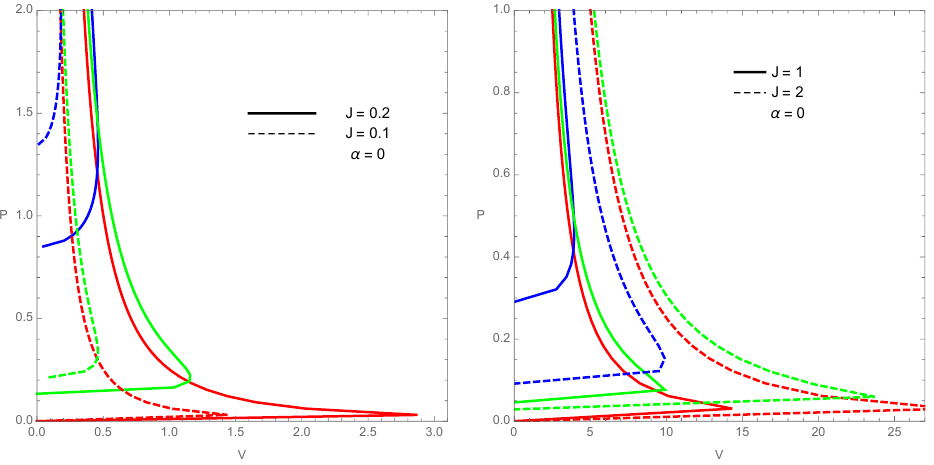
Figure 5 . PV diagram for (cid:11) = 0, (cid:13) = 1 (pure exotic BTZ black hole). The other parameters are J = 0 : 1 ; 1 ; 2 ; 3, and T = 0 : 001 (red), T = 0 : 5 (green), T = 2 (blue). In the case of exotic BTZ there is a value of the pressure for which the volume is equal to